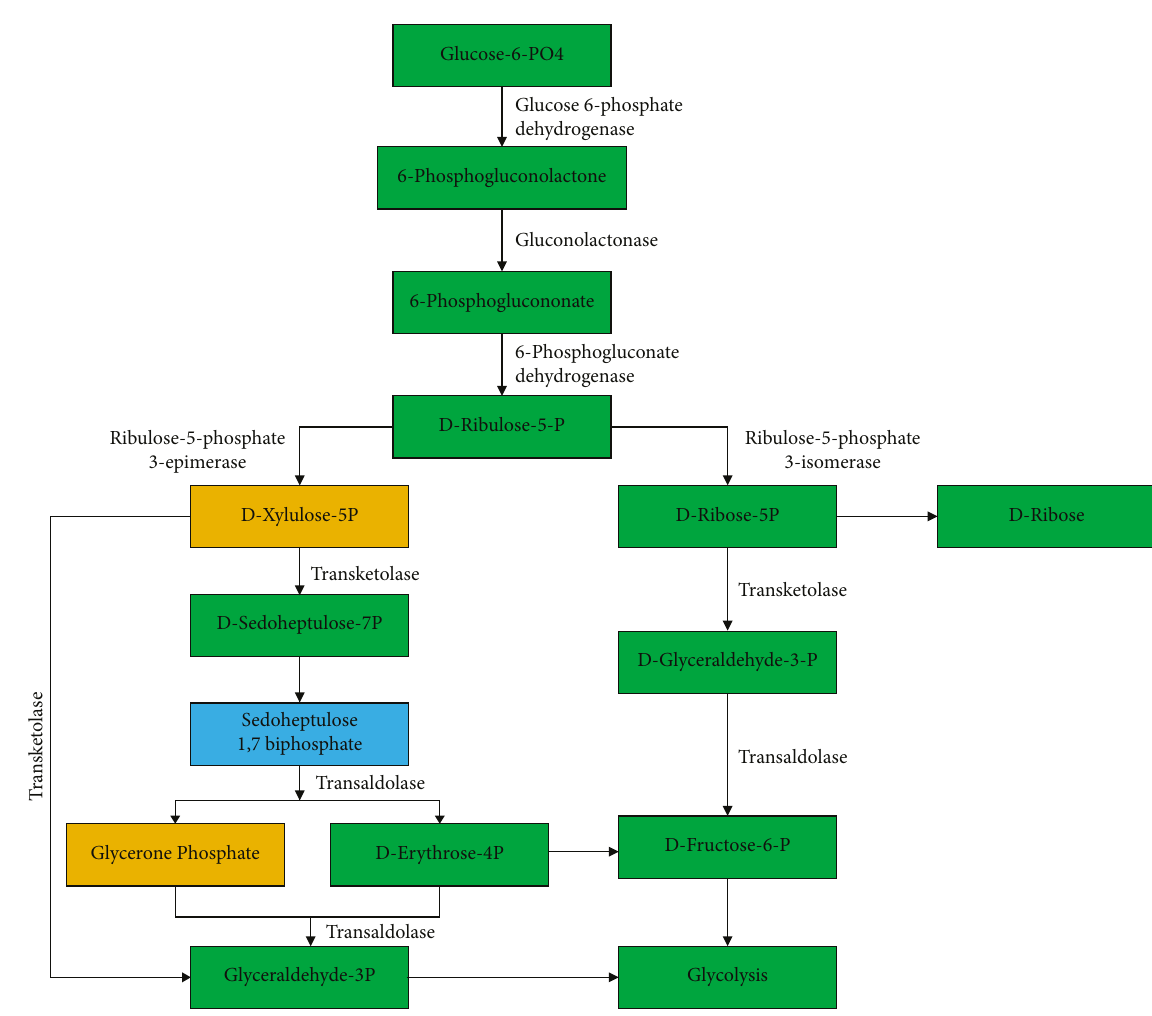
Figure 5: Predicted alternative metabolic paths in the pentose phosphate pathway. The compounds (D-xylulose-5P and glycerone phosphate) highlighted in gold represent the predicted alternative paths to the fi nal product. The compound (sedoheptulose 1,7 biphosphate) highlighted in blue is the predicted nonannotated compound in the